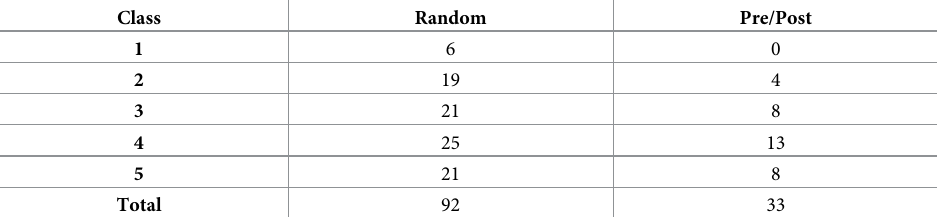
Table 1. Number of sites per LAMAP class in the two Tanana Valley analyses. ‘Random’ shows the results obtained when the model was built on 90 randomly selected sites and tested with a different set of 92 randomly selected sites. ‘Pre/Post’ shows the results obtained when the model was built on pre-10,000 cal BP sites and tested with post-10,000 cal BP sites.